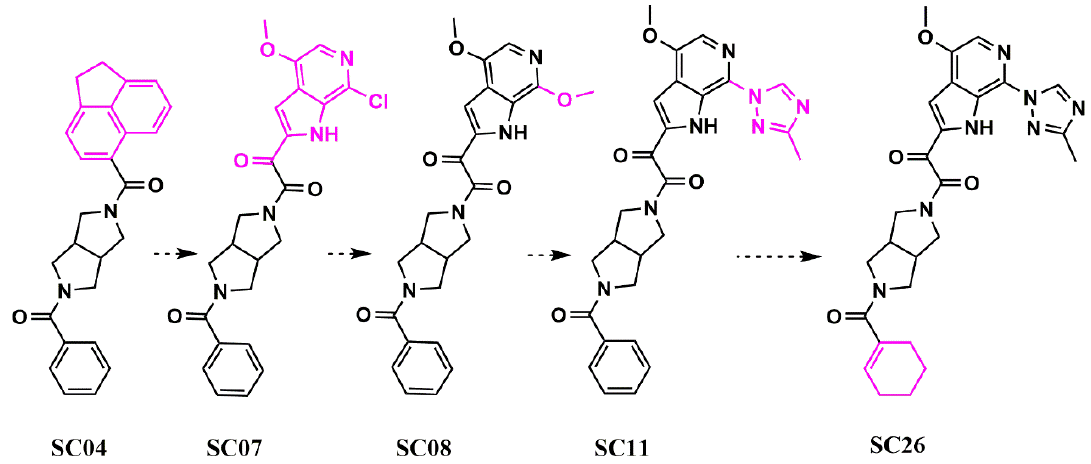
Figure 12. Evolution (from left to right) of HIV ‐ 1 entry inhibitors to improve potency and ADME properties. Structural changes between each compound are highlighted in pink.